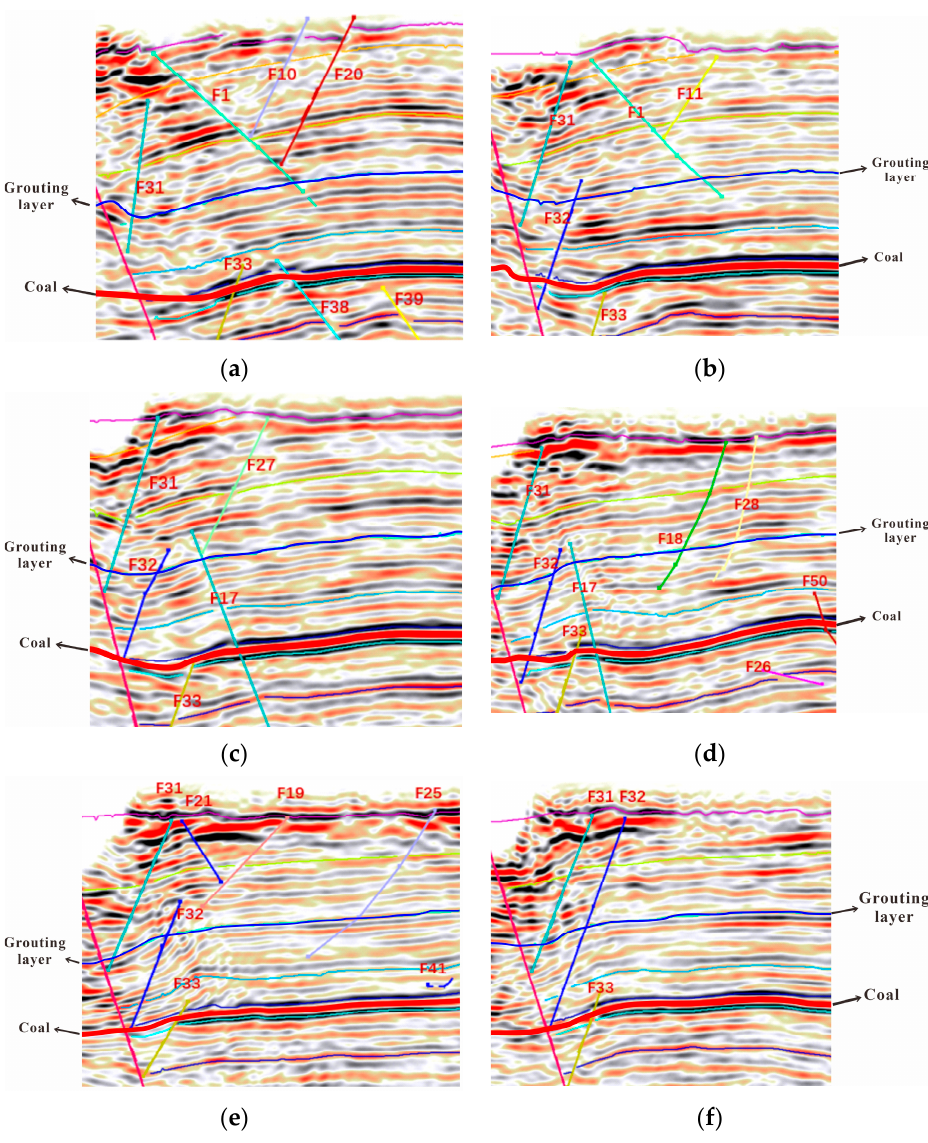
Figure 11. Profiles of seismic interpretation results: ( a ) Profile 1-1; ( b ) Profile 1-2; ( c ) Profile 1-3; ( d ) Profile 1-4; ( e ) Profile 1-5; ( f ) Profile 1-6.